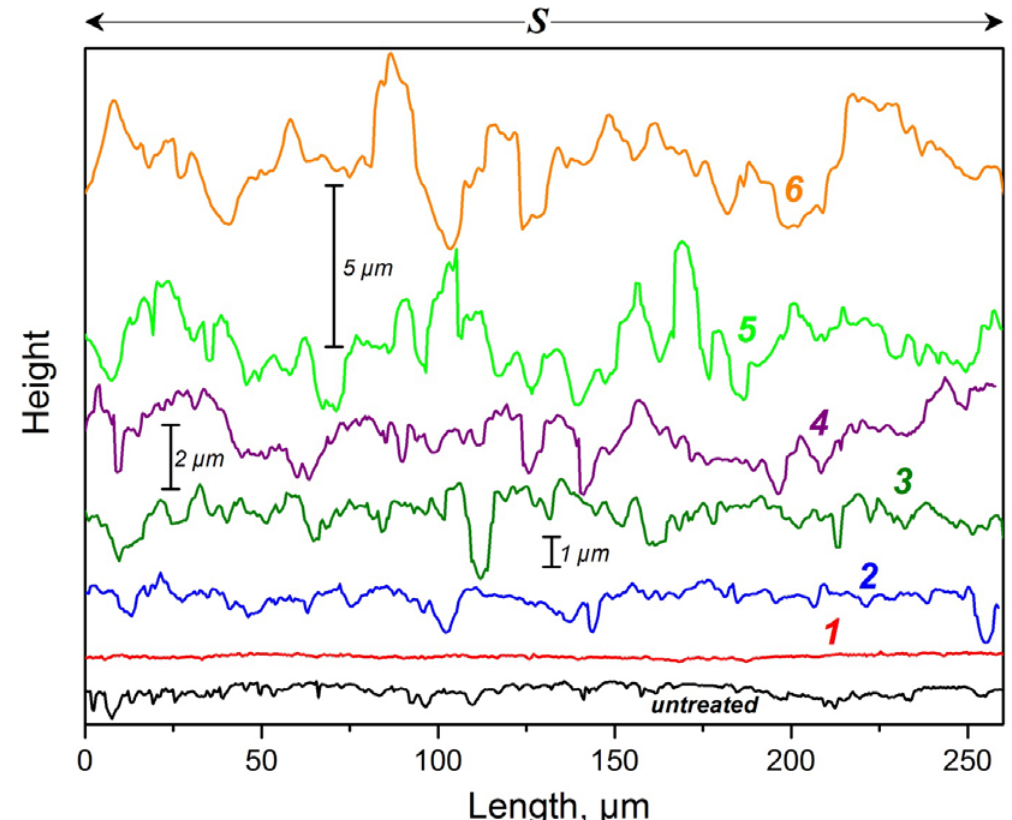
Figure 11. Comparison of the profiles of all